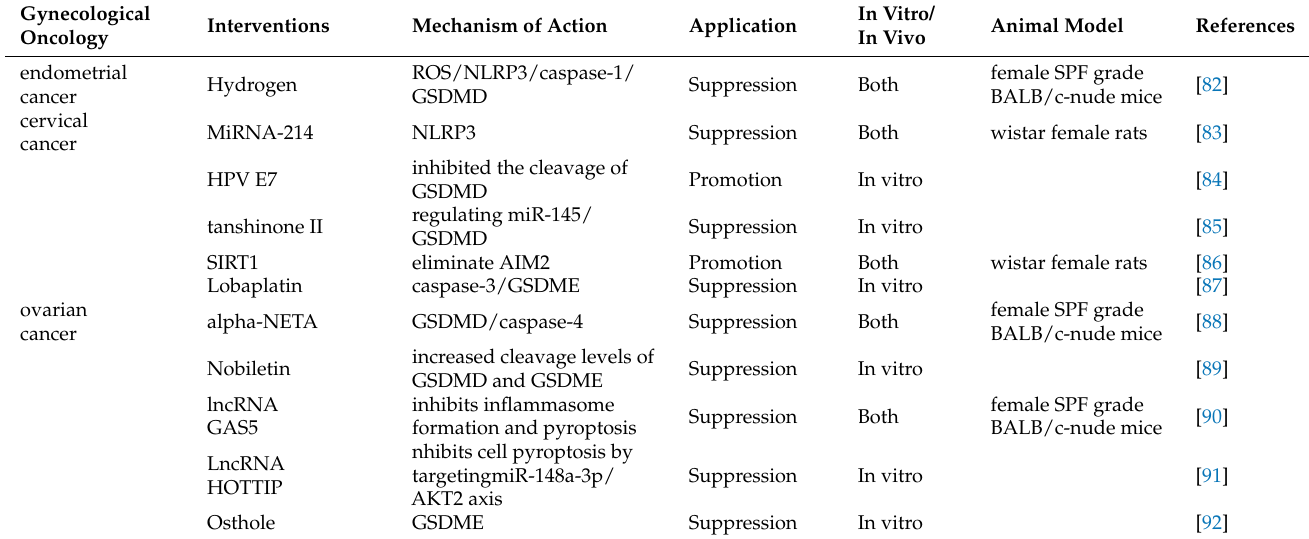
Table 3. Summary of studies on the role of pyroptosis and related compounds in gynecological oncology. Gynecological